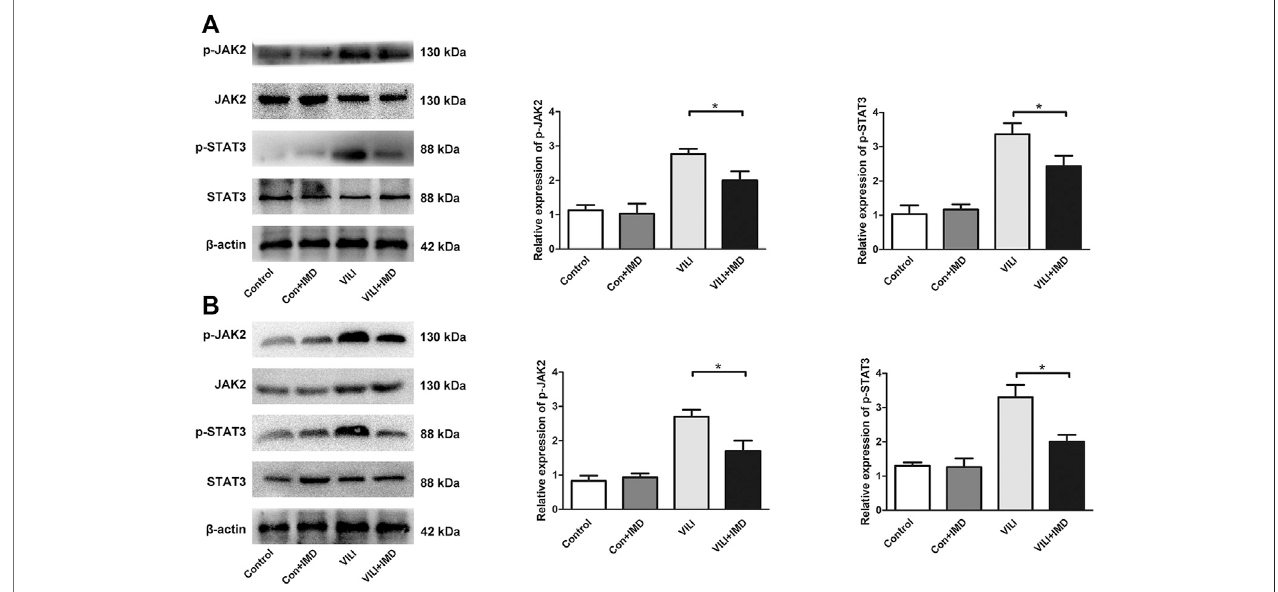
FIGURE 4 | IMD inhibited the JAK2/STAT3 pathway in VILI. Western blot analysis of p-JAK2, JAK2, p-STAT3, STAT3 and β -actin in lung tissues (A) and ECs (B) . * p < 0.05.